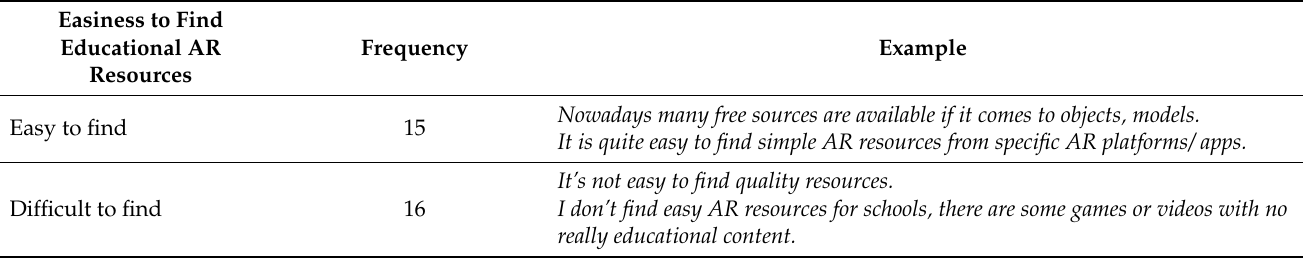
Table 7. Easiness to find educational AR resources for integrating ARinE.